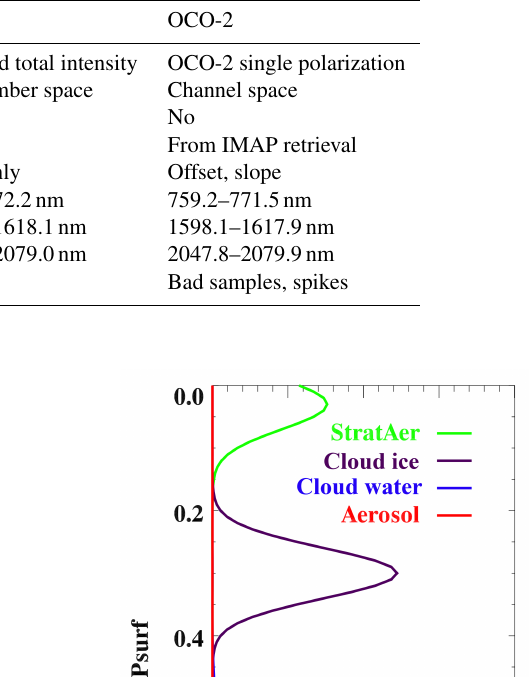
Table 4. ACOS retrieval differences between GOSAT and OCO-2.